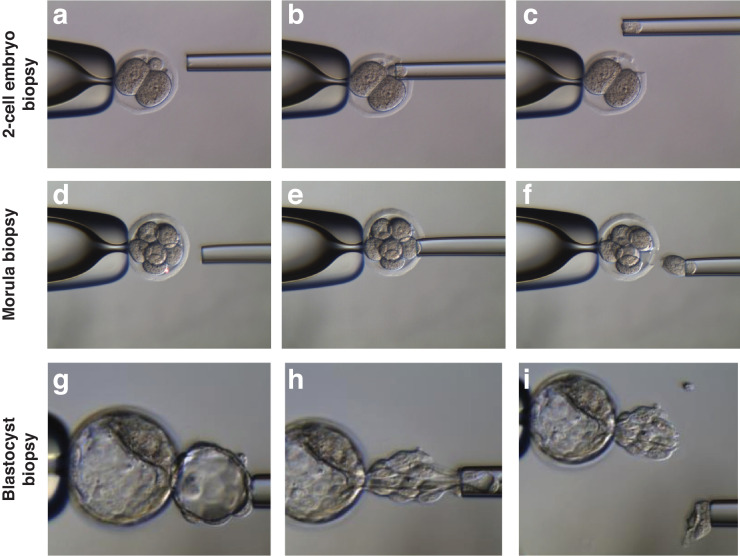
Representative pictures of biopsy procedure in MST embryos for mtDNA heteroplasmy quantification.(a-c) Second polar body biopsy of a 2 cell stage MST embryo. (d-f) Blastomere biopsy of a 8 cell stage MST embryo. (g-i) Trophoectoderm biopsy of a MST blastocyst embryo.